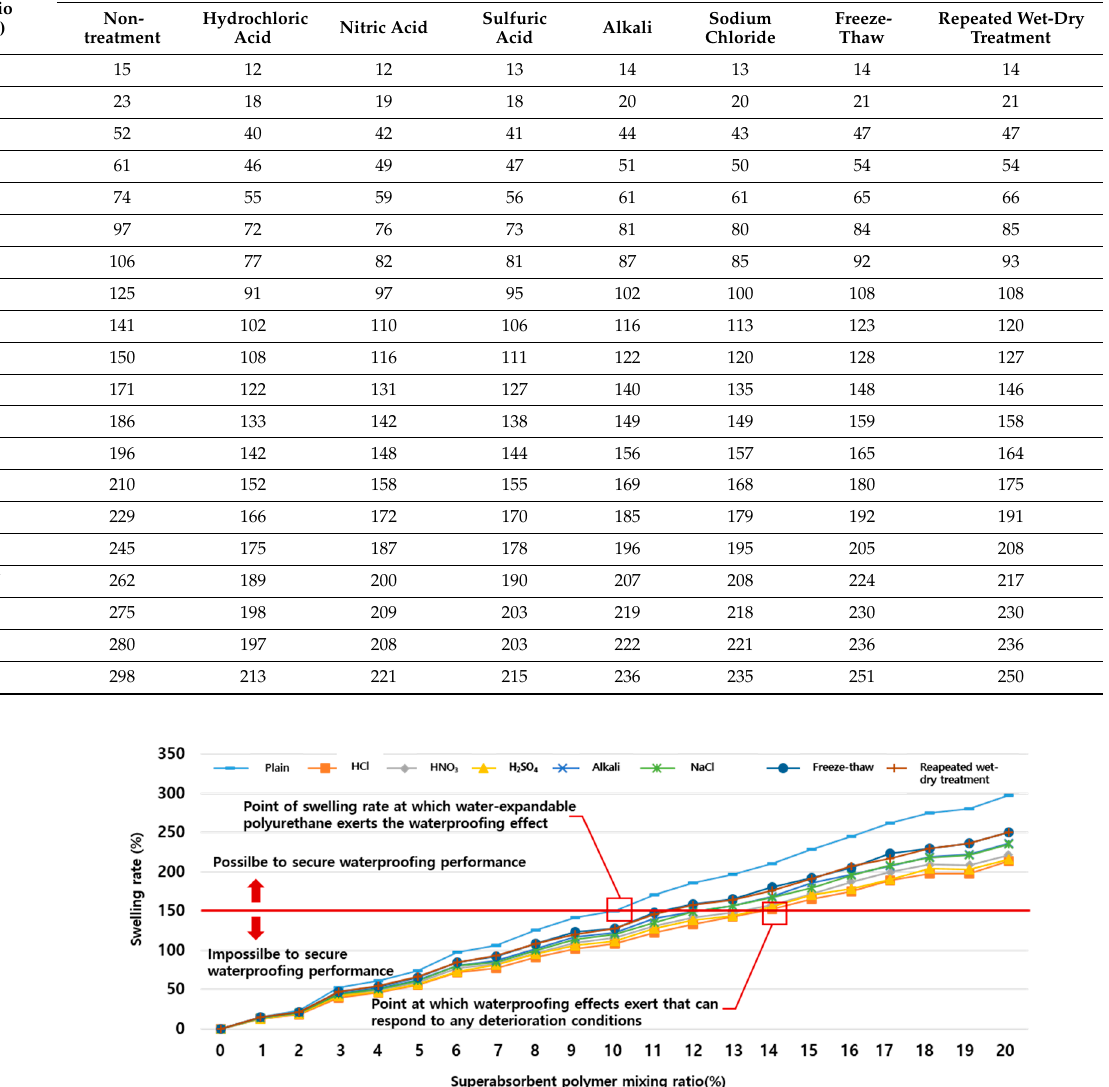
Figure 13. The swelling rate evaluation results under deterioration conditions according to the superabsorbent polymer content.